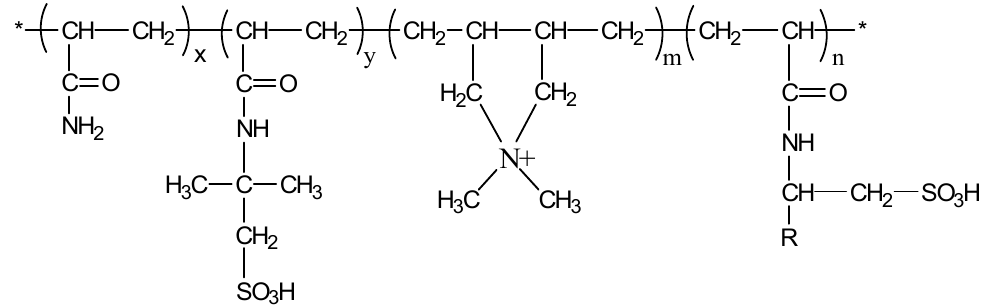
Figure 2. Molecular structure of the self-crosslinking emulsion thickener. The intrinsic viscosity [ η ] of ZJL-1 was measured by a self-made dilution Ubbelohde viscometer, and the relative molecular mass was estimated according to the Mark-Houwink [ η ] = KM α equation, where α = 0.8, K = 4.75 × 10 − 3 mg/L, the relative molecular mass M